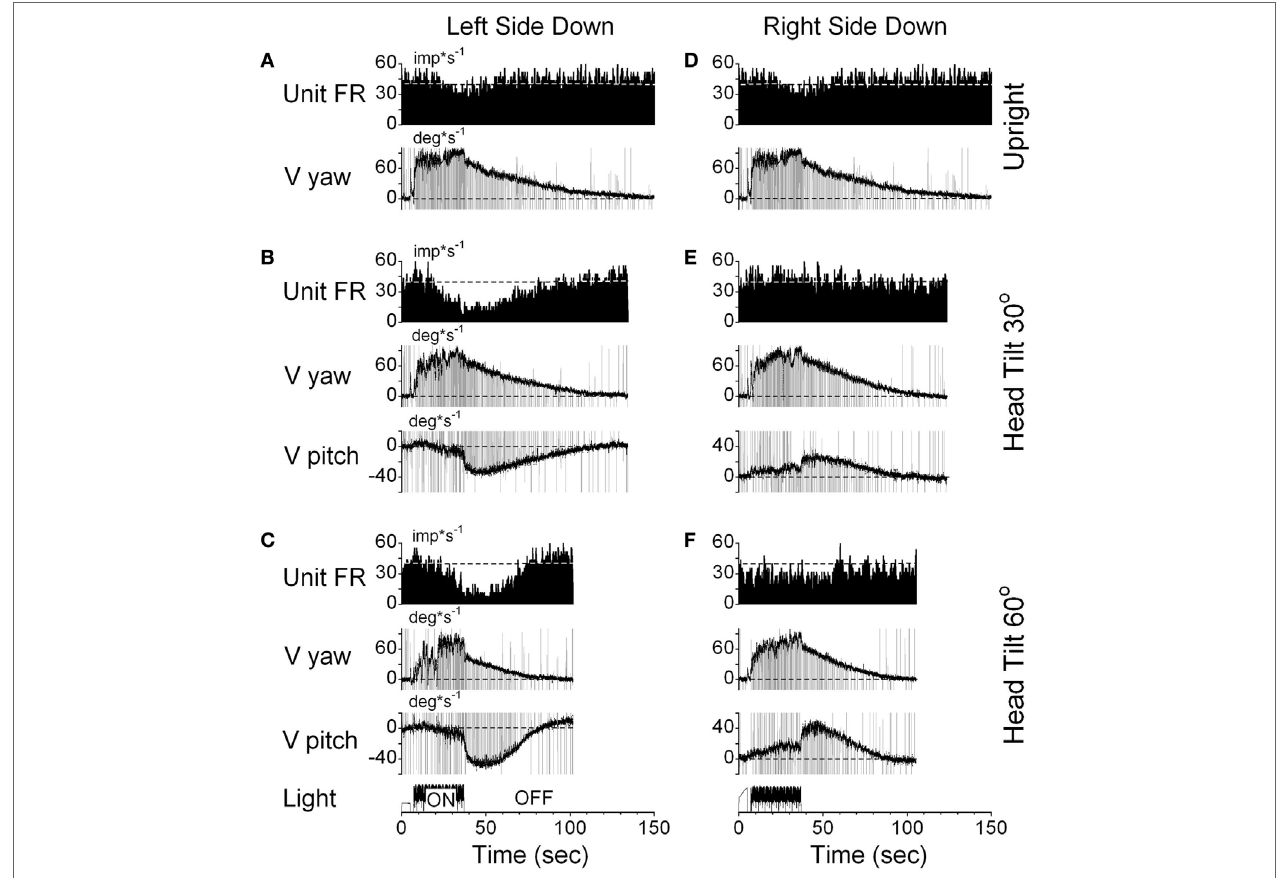
FigUre 10 | Changes in the firing rate (Unit FR) of a VPS neuron that received convergent input from the contralateral posterior canal during optokinetic nystagmus (OKN)/OKAN in the left side down (a–c) or right side down (D–F) positions. For each position, the neuron was tested while upright (a,D) or while tilted 30° (B,e) or 60° (c,F) . (a,D) are replicated from the same data. V yaw is the yaw slow phase eye velocity and V pitch is the slow phase pitch eye velocity. ON denotes the OKN interval, and OFF denotes the OKAN interval. Data in panel (D) are duplicate of panel (a) . This was done to organize data in columns to simplify